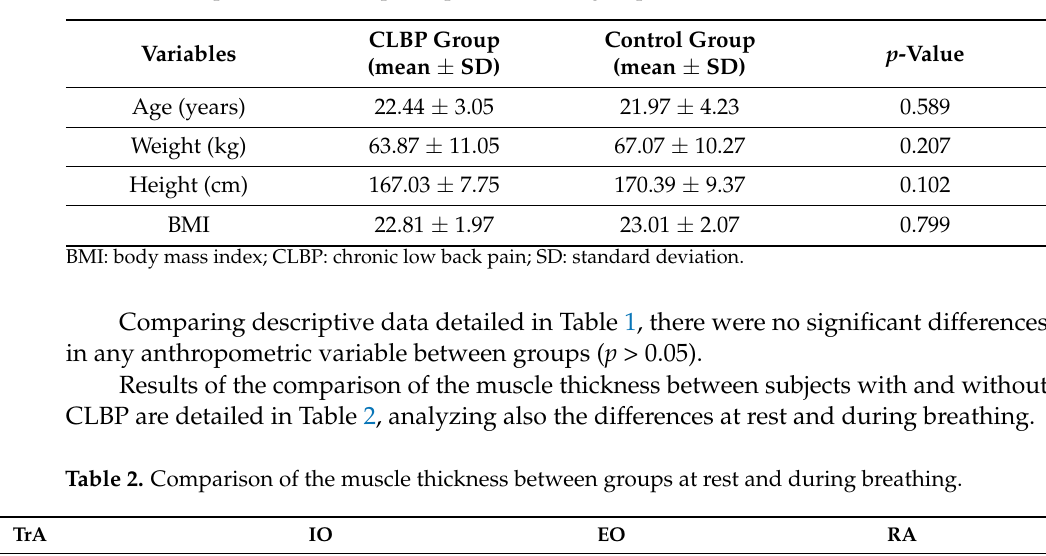
Table 1. Descriptive data of the participants for both groups. Variables